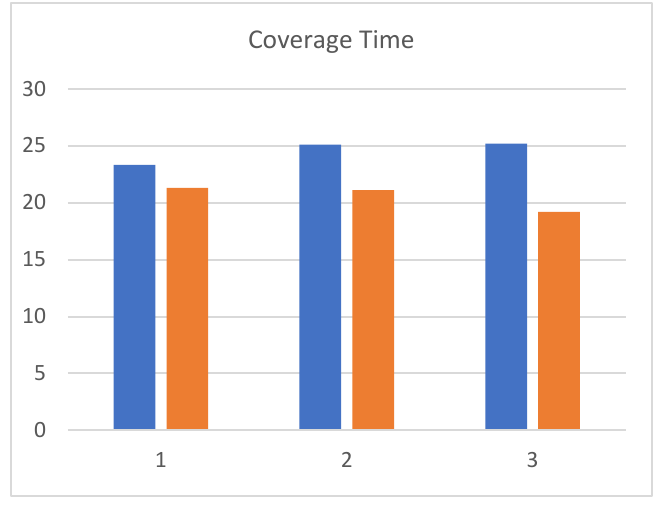
Figure 9. UAV Coverage Time.